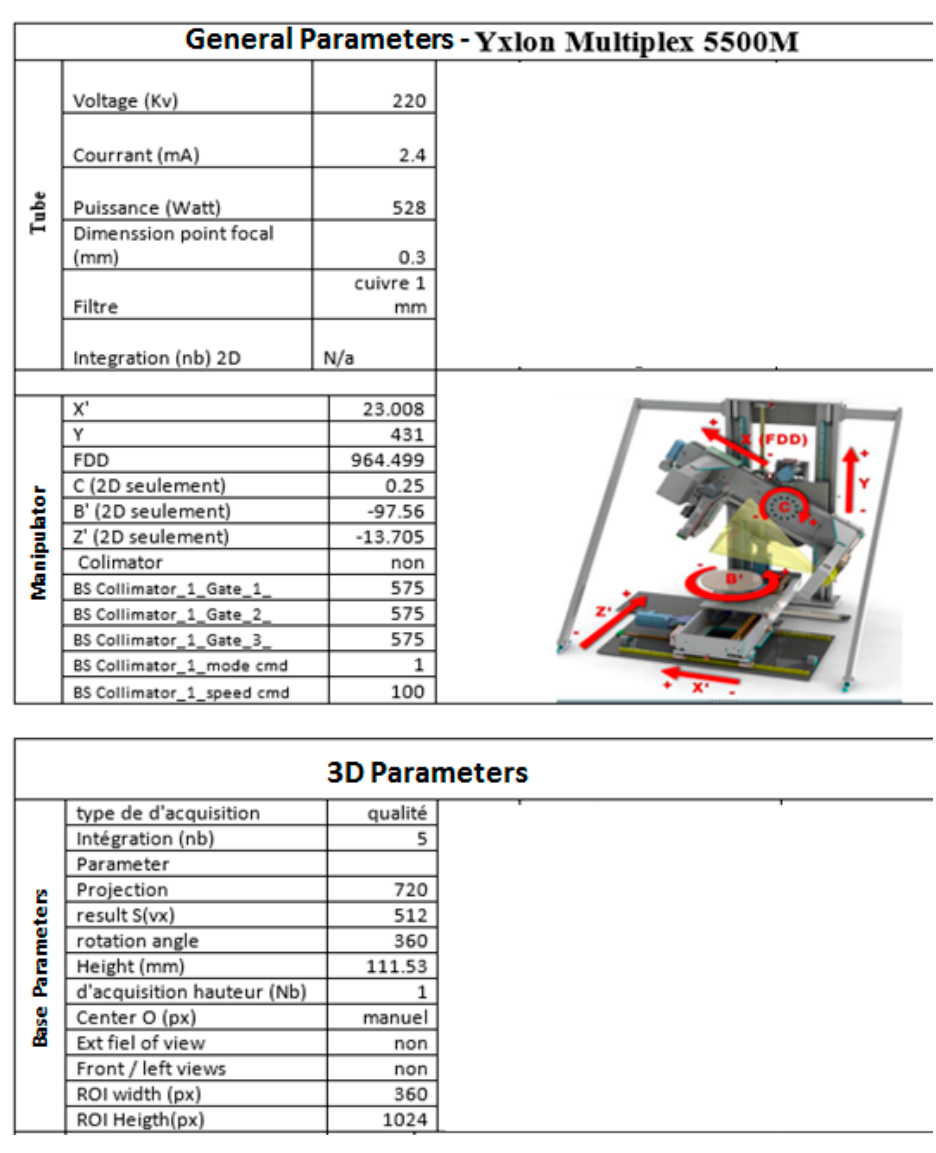
Figure A1. X-ray tomographic imaging parameters.